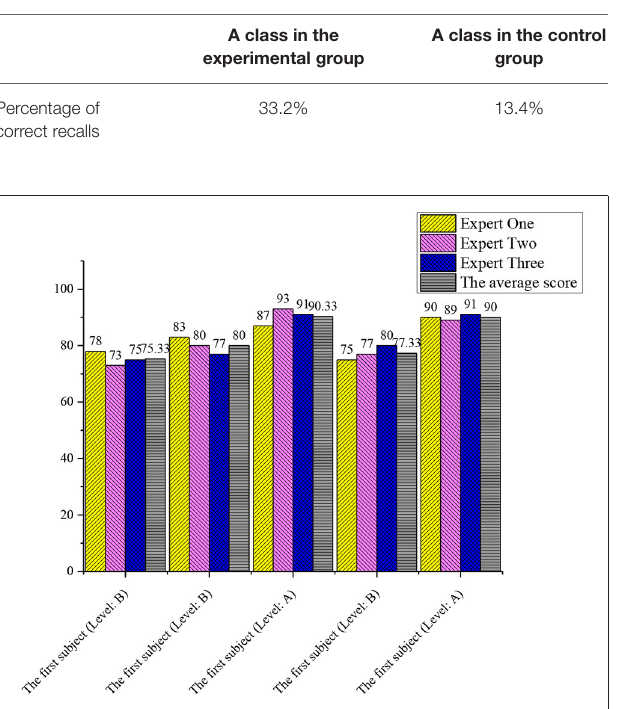
TABLE 5 | Percentage of the students correctly recalling the three or more subjects.